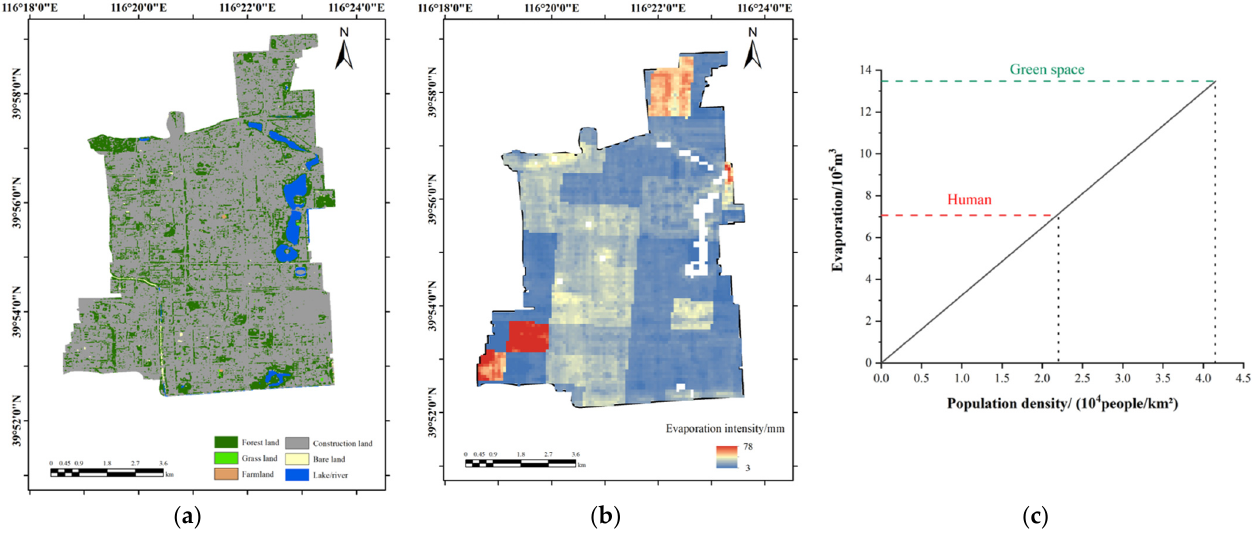
Figure 6. Land use types and evaporation from human body in Xicheng District. ( a ) Land use types; ( b ) evaporation distribution map; ( c ) comparison between human and green space evaporation.